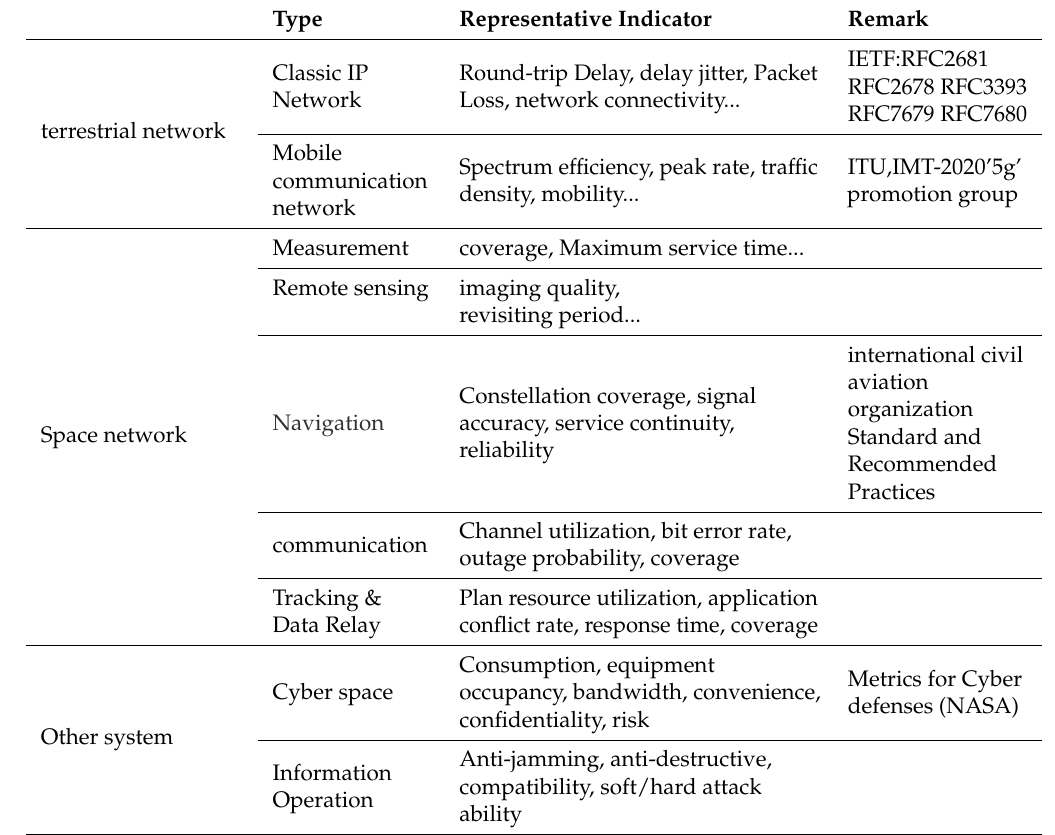
Table 1. Indicator investigation of various related